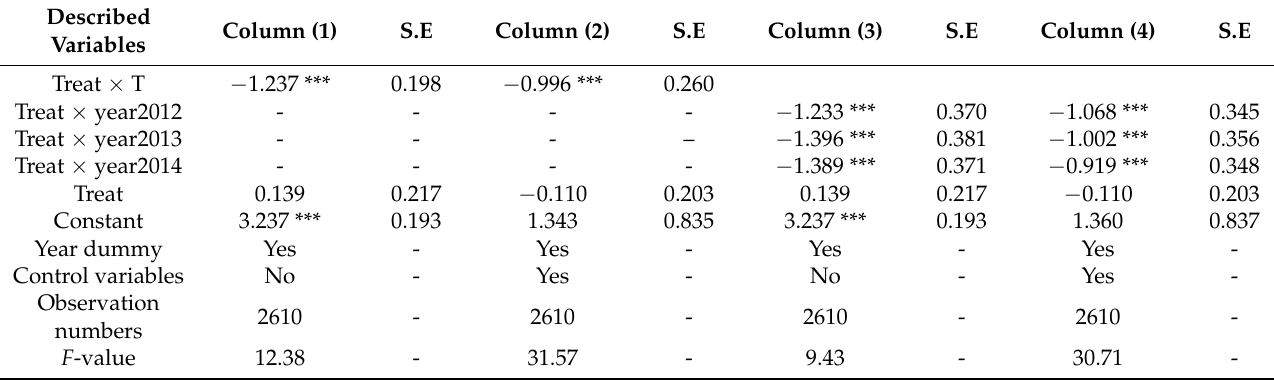
Table 6. Outcomes of PSM-DID method.